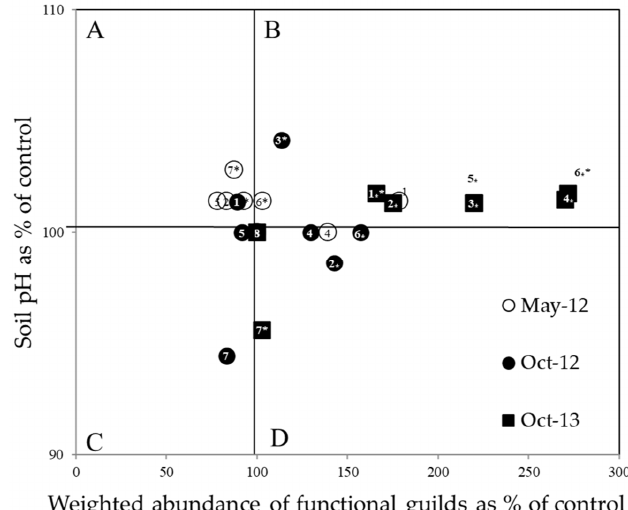
Figure 4. Integrated Production Efficiency (IPE) of amending sandy clay loam soil with either animal (AC) or plant (PC) based compost applied at 135, 203 or 270 kg N/ha planted with processing cultivar on soil pH ( y -axis) and weighted abundance of functional guilds (WAFG, x -axis) of nematodes at planting in May 2012 (May-12) and harvest in October 2012 (Oct-12) and 2013 (Oct-13) growing seasons fitted the IPE model. Numbers 1–3 refer PC at a rate of 135, 203 and 270 kg N/ha, respectively and 4–6 refer AC at a rate 135, 203 and 270 kg N/ha, respectively, 7 and 8 refer urea and non-amended check, respectively. * Treatments with subscripts and superscripts asterisks (*) indicate significantly different form 100% for WAFG and soil pH, respectively, using one-tailed t -test at α = 0.05. The soil amendment rates and the soil pH data presented here are the same as those in Table S2. The WAFG data presented here are the same as those in Table 1.